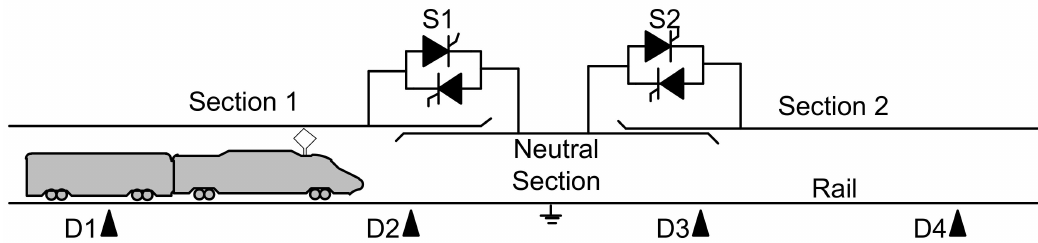
Figure 2. Medium-voltage AC static switch solution to feed the neutral section (NS) in a high-speed railway (HSR) system.